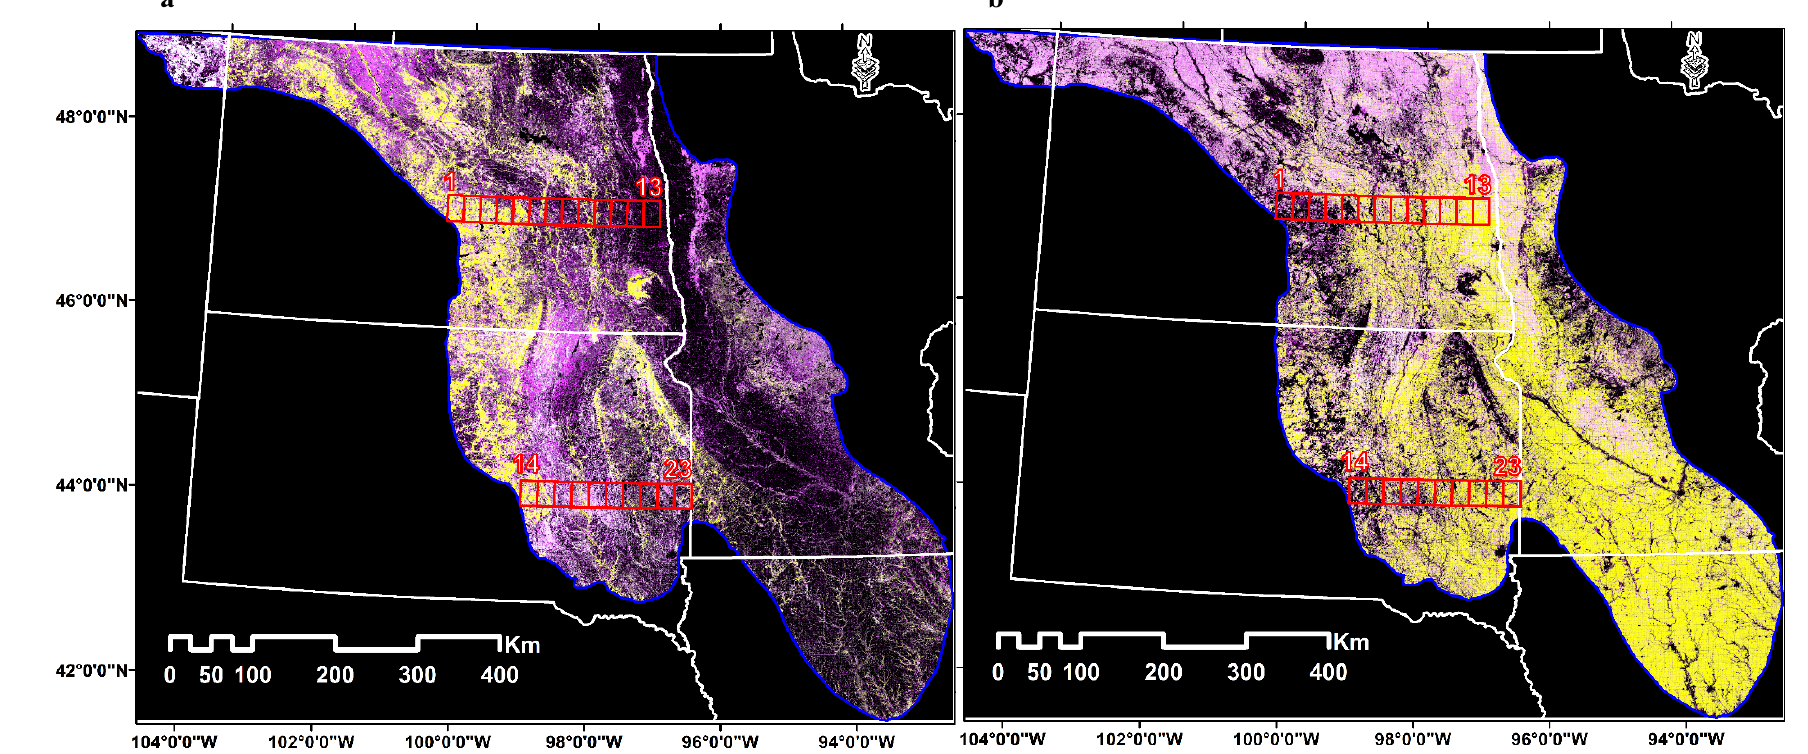
Figure 2. Persistency maps for ( a ) grassland / pasture, and ( b ) cropland. The persistency map is a false-color composite of CDL (Crop Data Layer) time series where: Red color plane was assigned to maximum % cover, Green to average % cover, Blue to range (max %-min %). Interpretation: Yellow → stable core areas, White → unstable core areas, Magenta → unstable periphery, Black → cover does not occur. Transects of AMSR pixels are outlined in red. Note that the grassland / pasture cover types ( a ) are dominated by shades of magenta to purple indicating higher interannual variation and low averages [36,37] .